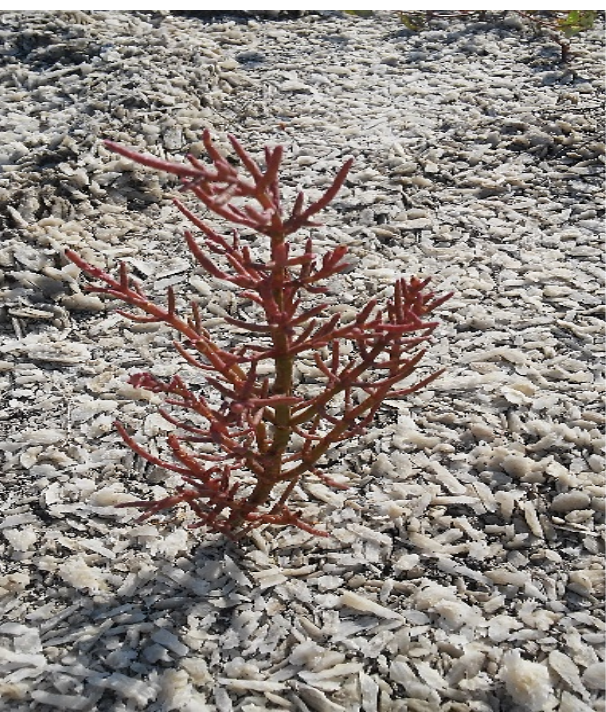
FIGURE 2 - Salicornia europaea